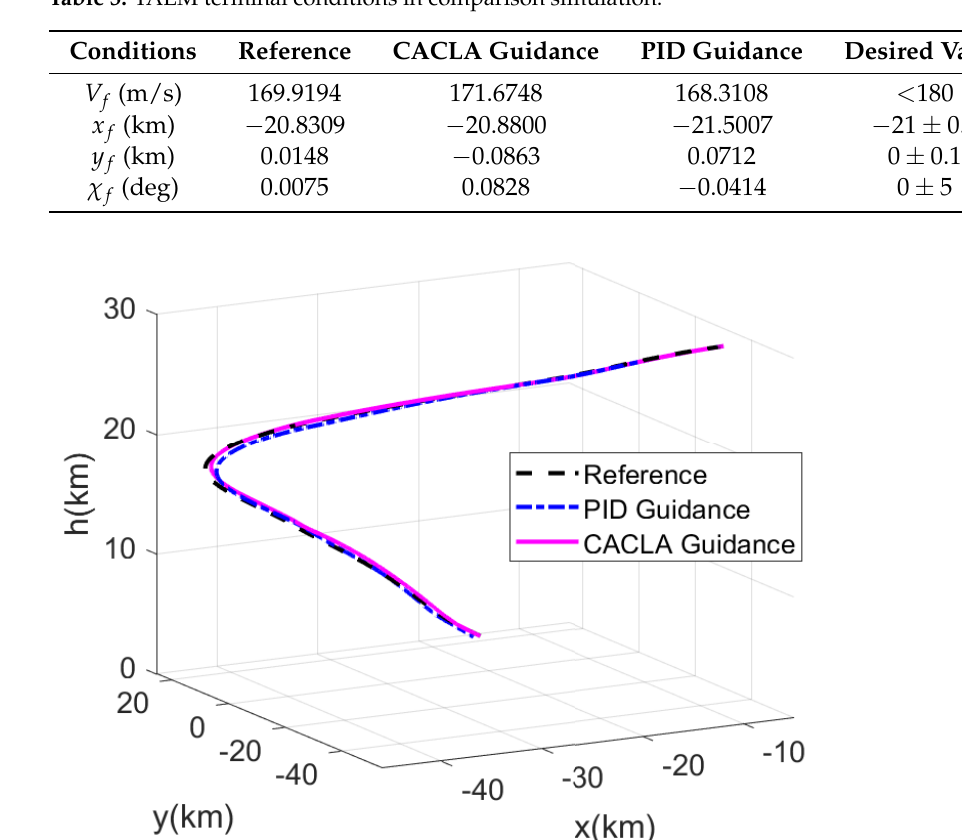
Table 3. TAEM terminal conditions in comparison simulation.